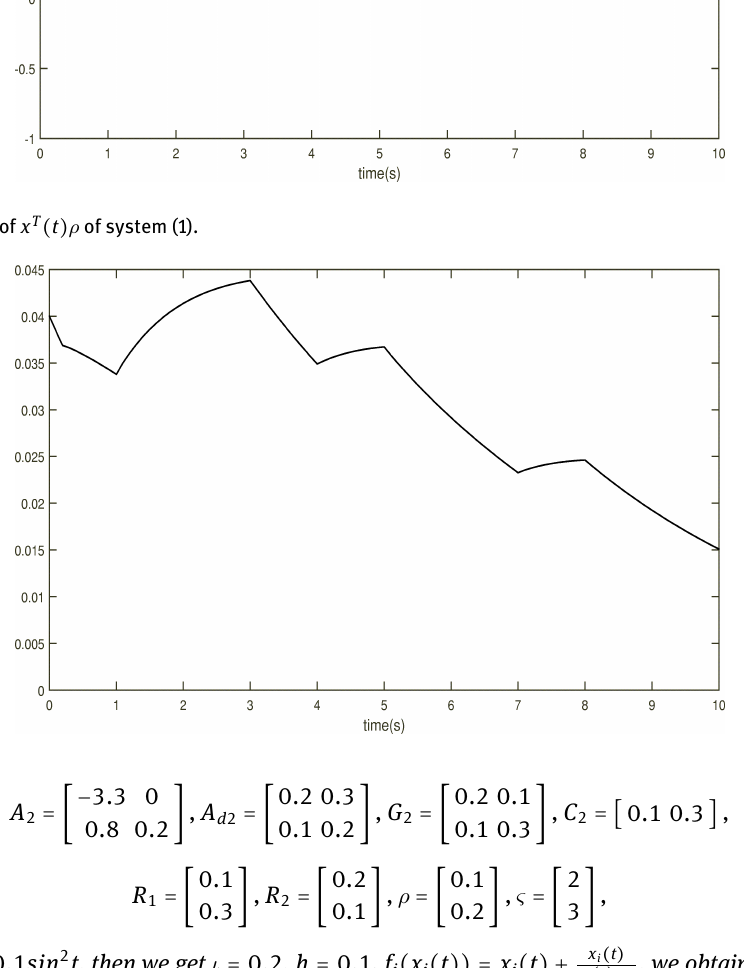
Fig. 3. The evolution of x T ( t ) ρ of system